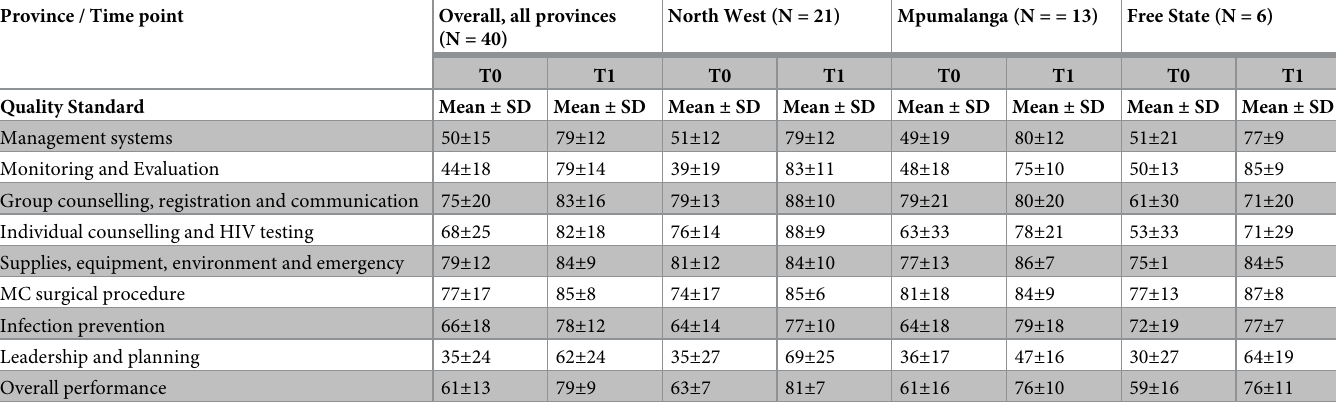
Table 1. Descriptive statistics for quality of service mean scores at baseline and after CQI support intervention disaggregated by quality standards. Province / Time point Overall, all provinces North West (N = 21) Mpumalanga (N = = 13) Free State (N = 6) (N = 40) T0 T1 Quality